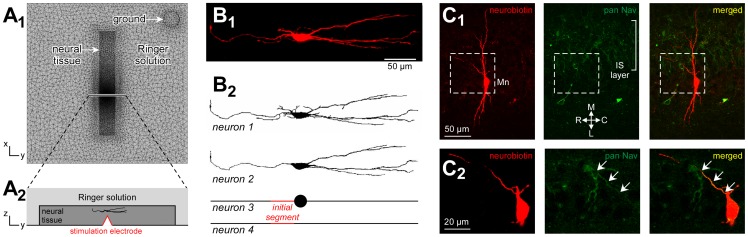
Modeling approach.Simulations were performed to compare theoretical and experimental estimations of the spatial extent of electrical microstimulation. A: A 3D Finite Element Model (FEM) was used to compute the electrical potential field generated in the neural tissue by an electrical stimulation. The model geometry corresponded to the experimental MEA, including the chamber, the neural tissue, one 3D electrode (which shape was approximated by a cone with a height of 80 µm and a base diameter of 80 µm) and the cylindrical ground electrode (height  = 2.7 mm, diameter  = 2 mm). This volume was subdivided into two regions, representing the aCSF solution (side length: 2 cm, height: 3 mm, conductivity σ = 1.65 S/m) and the neural tissue (length: 13 mm, width: 2 mm, height: 200 µm, σ = 0.10 S/m). B: The FEM-calculated extracellular potential field was then applied to compartmentalized motoneuron models in order to determine theoretical activation thresholds. Four different neurons were considered (B2), the most complex of them (1895 compartments) being a 3D reconstruction of a Neurobiotin-injected motoneuron considered in the experimental study (B1). These neuron models were equipped with passive properties in the soma, dendrites and most of the axon. Voltage-dependent Na+ and K+ channels were located in the initial segment of the axon (length = 34 µm), leaving from the soma, in accordance with the immunolabelings (C). C: Confocal projection of a neurobiotin-injected motoneuron (red) and anti-sodium channel labeling (pan Nav, green). C1: Global view of the neuron and the layer of initial segments (IS), oriented in the medio-lateral direction (60 optical sections). C2: Close-up in the perisomatic region (6 optical sections), revealing the localization of the sodium channels in the IS of the axon (merged image, yellow, see arrows). In n = 3 experiments, the IS had a length of 34 +/− 3 µm. [C: caudal; M: median; L: lateral; R: rostral].